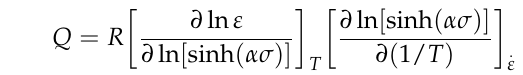
Figure 6. Evaluating the value of n by plotting ln[sinh( ασ )] versus ln έ .